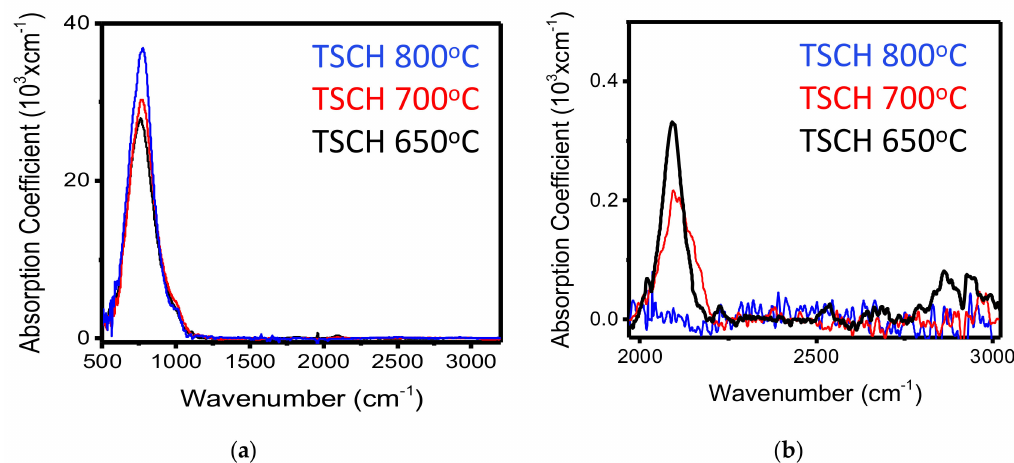
Figure 6. ( a ) FTIR-normalized absorbance coefficient for as-deposited SiC films grown from TSCH at three different deposition temperatures (650 ◦ C, 700 ◦ C, and 800 ◦ C); ( b ) section around the stretching transverse optical Si–H absorption located at 2090 cm − 1 , enlarged to better capture relative Si-H peak size.